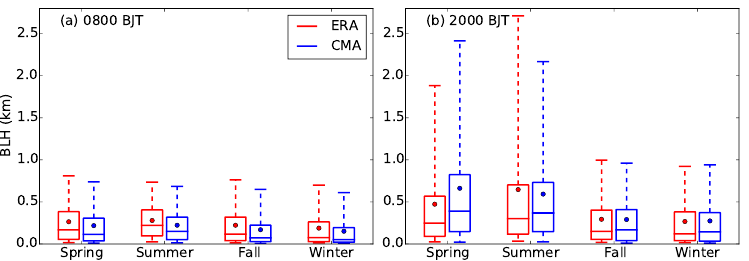
Figure 5. Box-and-whisker plots showing the 5th, 25th, 50th, 75th and 95th percentile values of ERA-BLH (in red) and CMA-BLH (in blue) during each season at (a) 08:00BJT and (b) 20:00BJT during the period from January 2011 to July 2015. The dot in each box indicates the mean value of BLHs. Note that there is larger uncertainty for the evening BLH climatologies in (b) .